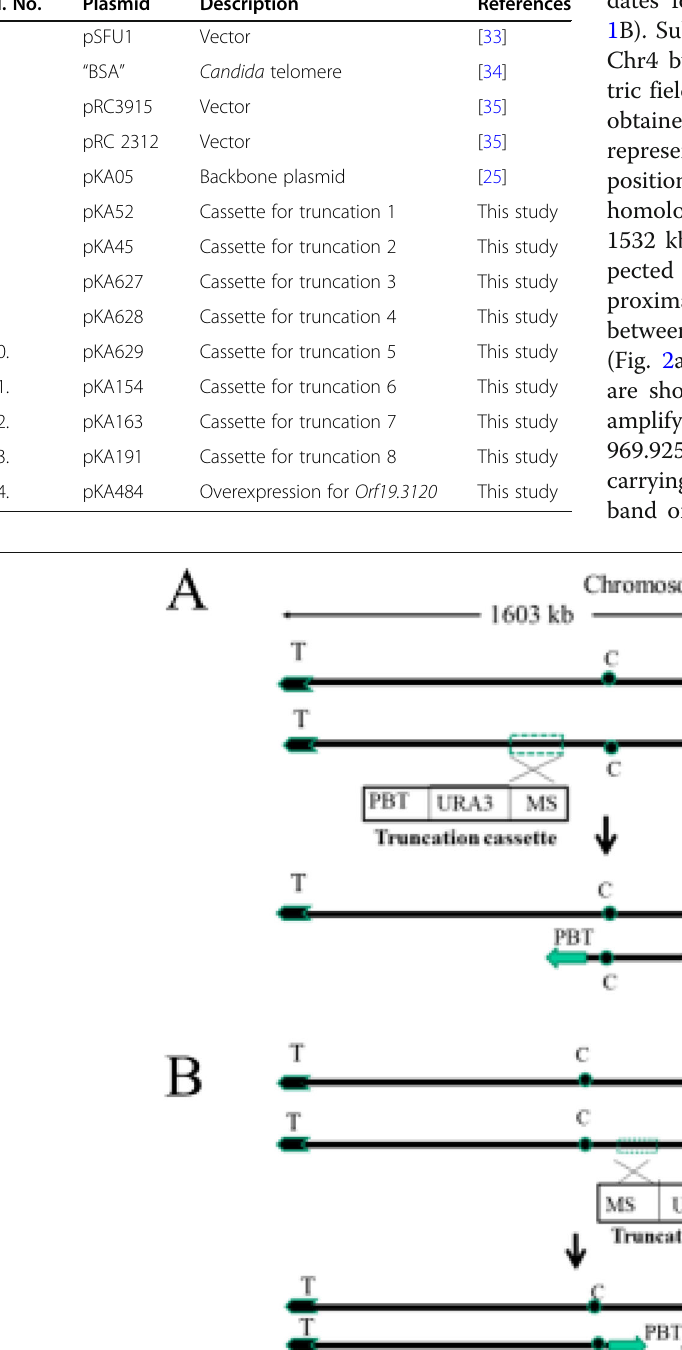
Table 2 List of the plasmids used in this study Sl. No.